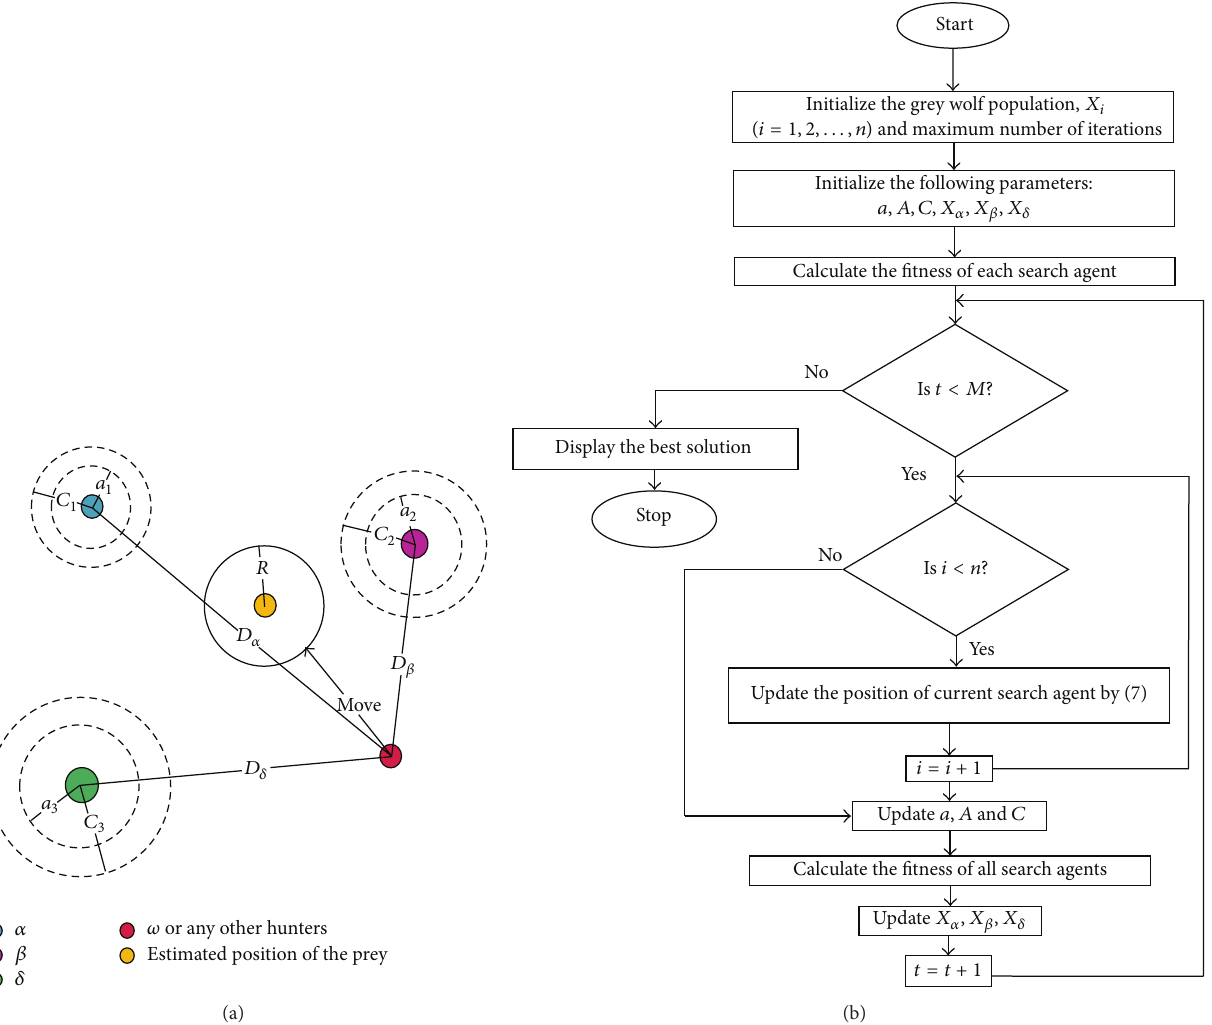
Figure 2: (a) Position update in GWO [25]. (b) Flowchart of the grey wolf optimization algorithm.